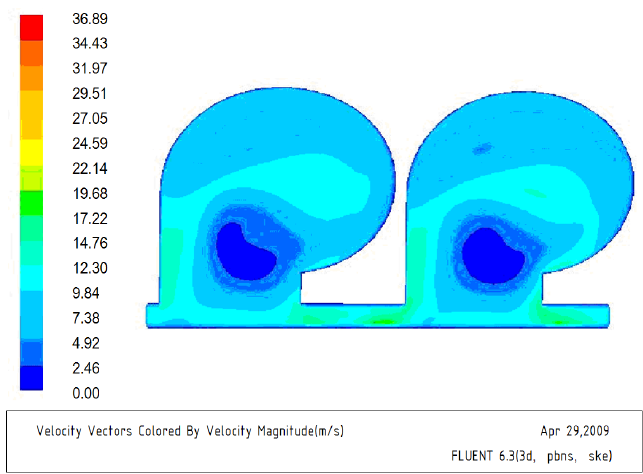
Figure 11. Section velocity contours of two fans.